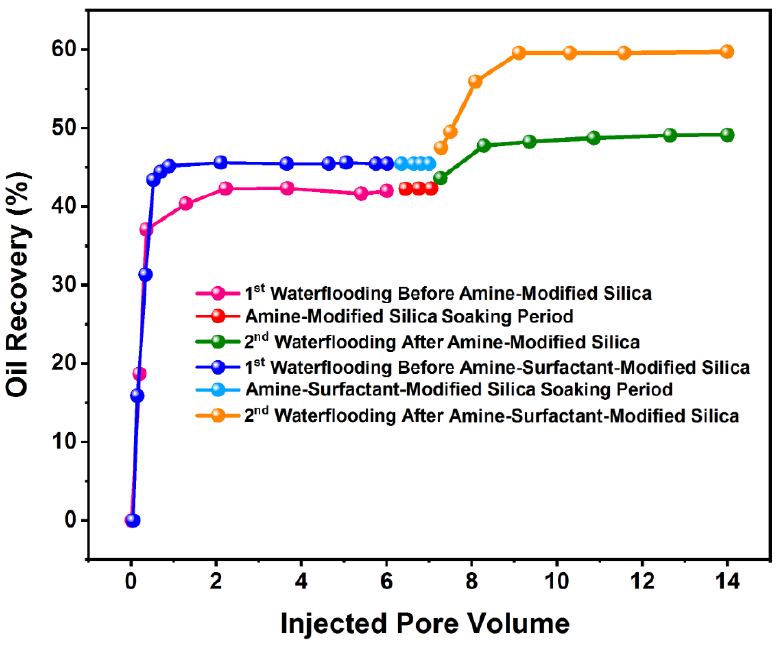
Figure 15. Oil recovery values before and after treatment with Si-NH 2 and Si-NH 2 -surfactant nanofluids.